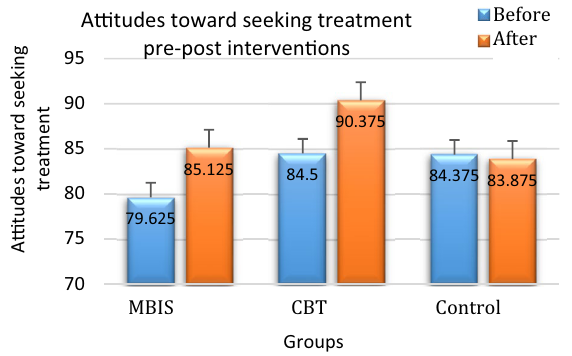
Figure 2. Attitudes toward seeking mental health treatment before and after the intervention.